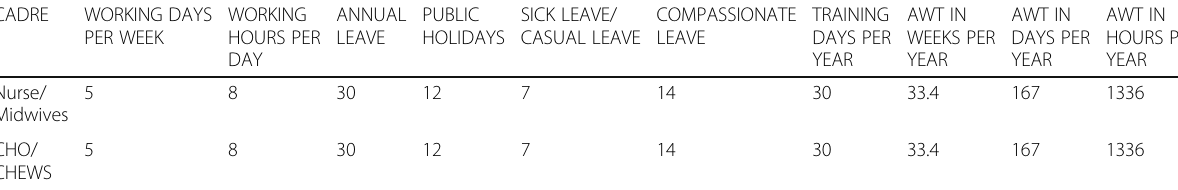
Table 1 Available working time (awt) for cadres of focus CADRE